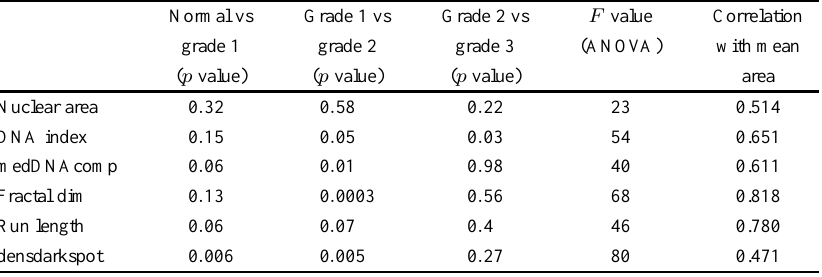
Post hoc comparisons of coefficients of variation. Tukey’s honest significant differences (HSD) for un- equal N was used to determine significance values for differences between the indicated groups. The F -statistic and correlations with mean area are also